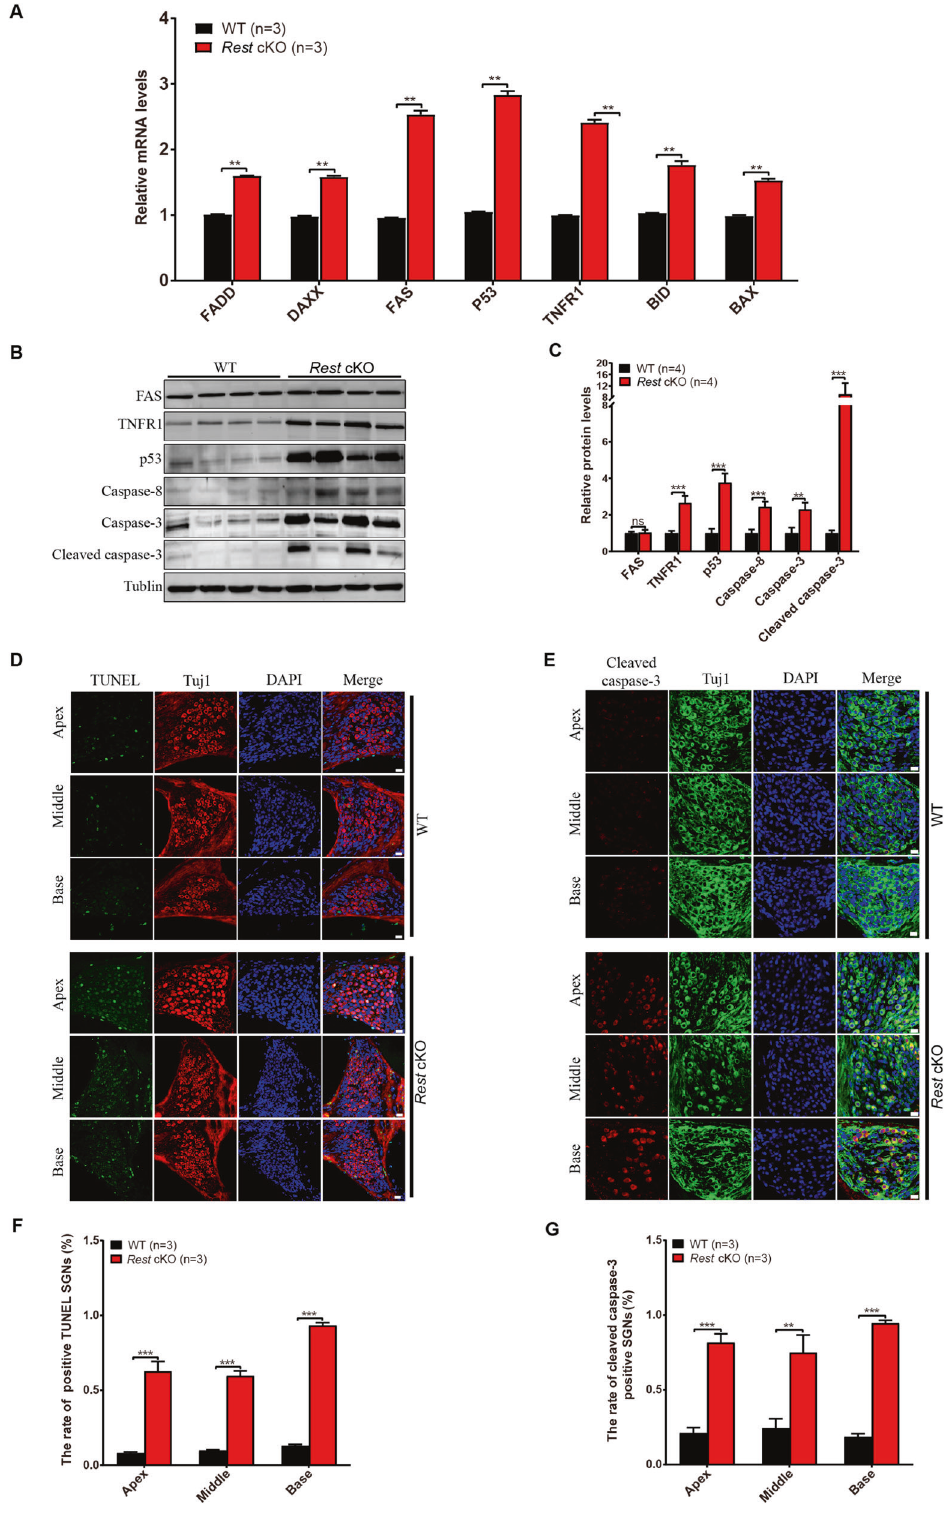
Fig. 4 REST de fi ciency induced apoptosis of SGNs and HCs in 3-month-old mice. A mRNA levels of apoptosis-related genes showed an increase in the cochlea of Rest cKO mice. B , C Expression of apoptosis-related protein in cochlea from WT and Rest cKO mice was measured by Western blot. D TUNEL staining showed the apoptosis of SGNs in apex, middle, and base of the cochlea from WT and Rest cKO mice. Scale bar: 20 µm. E Expression of cleaved caspase-3 in cochlea from WT and Rest cKO mice. Scale bar: 20 µm. F , G Quanti fi cation of the number of TUNEL- positive cells and cleaved-caspase-3 cells in SGNs of WT and Rest cKO mice. Data are represented as mean ± SEM. ** P < 0.01, *** P < 0.001.